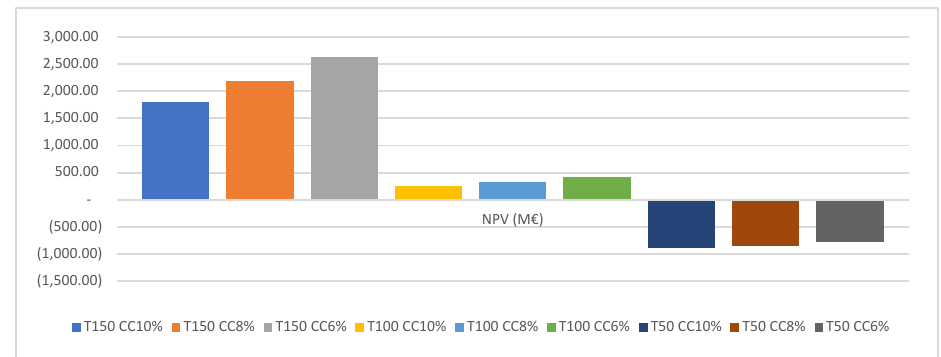
Figure 5. NPV results.